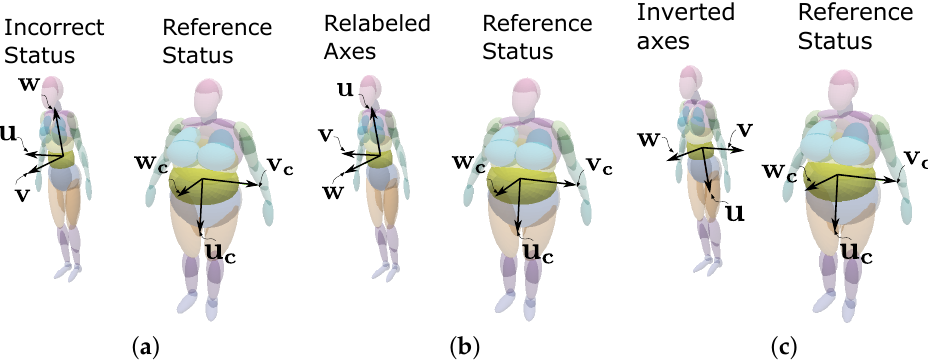
Figure 12. Minimization of the variation between orientations of corresponding ellipsoids with re-labeling and direction inversion . Yellow ellipsoids, 13.a Rectus Abdominalis from Tall Chubby (reference [ u c , v c , w c ] ) and Tall Slim (modified orientation [ u , v , w ] ). ( a ) Incorrect status for axes u , v , w . ( b ) Re-labeled axes u , v , w in ( a ). Correct labeling, incorrect direction for axes u , v , w . ( c ) Direction inversion of axes u , v , w in ( b ). Correct status for axes u , v , w .